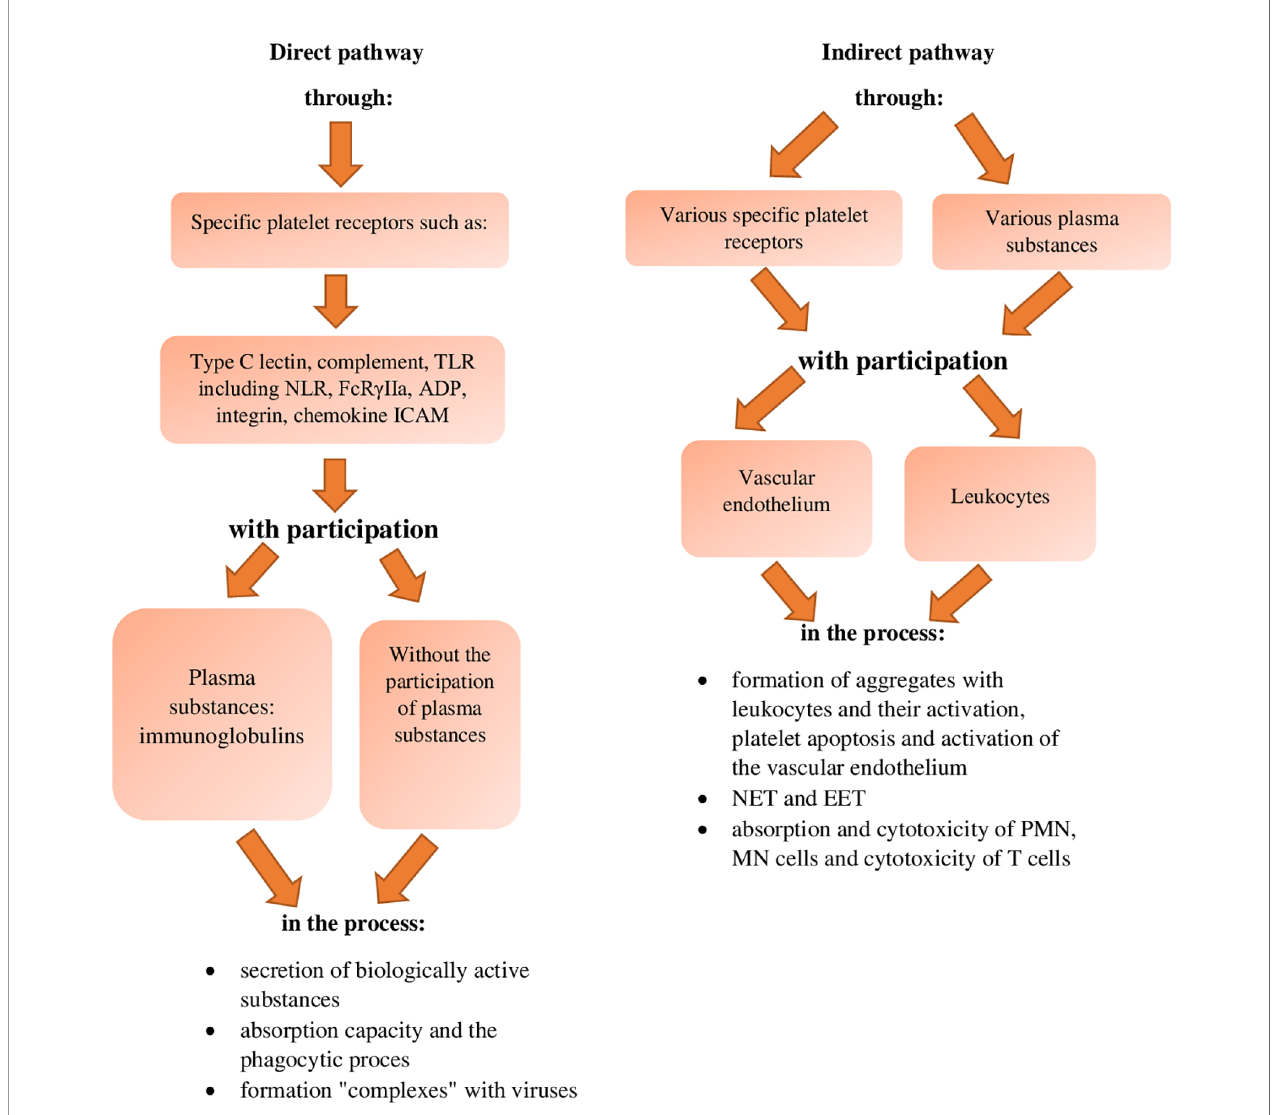
FIGURE 3 | Inactivating effect of platelets against viruses (references in the text). TLR, Toll like-receptors; NLR, nucleotide-binding oligomerization domain-like receptors; ADP, Adenosine diphosphate receptor; ICAM, intracellular adhesion